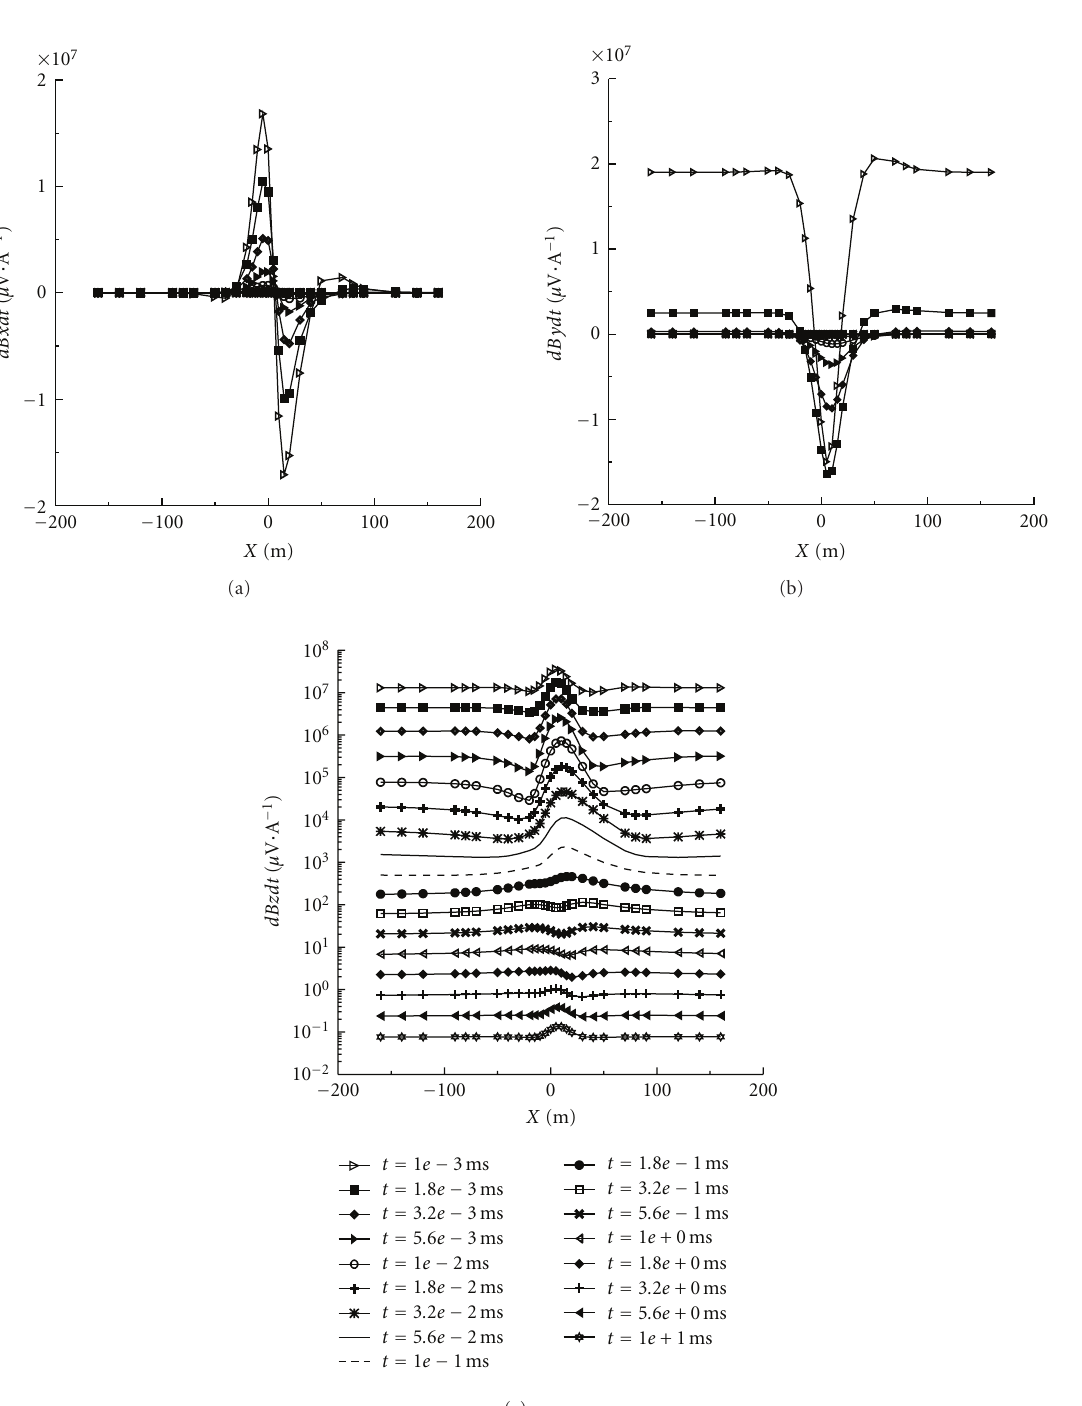
Figure 8: TEM profiles of inclined tabular orebody for (a) the horizontal EMF in x direction, (b) the horizontal EMF in y direction, and (c) the vertical